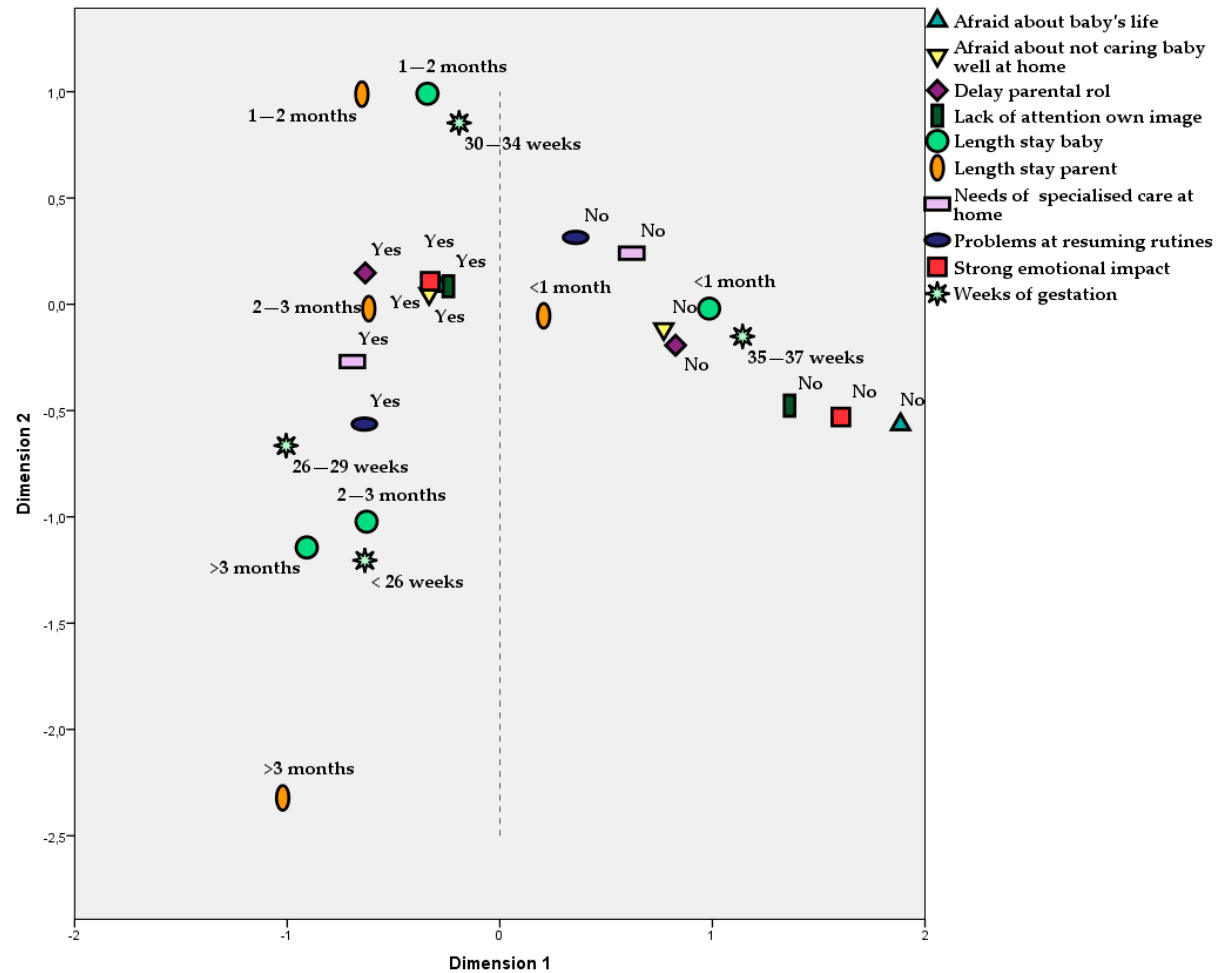
Figure 4. Multiple correspondence analysis for the main outcomes. This figure should be understood as follows: all the categories of the same outcome are represented by the same figure. If two categories of different outcomes are plotted closely, it means that they are positively associated, as occurs, for example, for String emotional impact = Yes and Lack of attention own image = Yes.